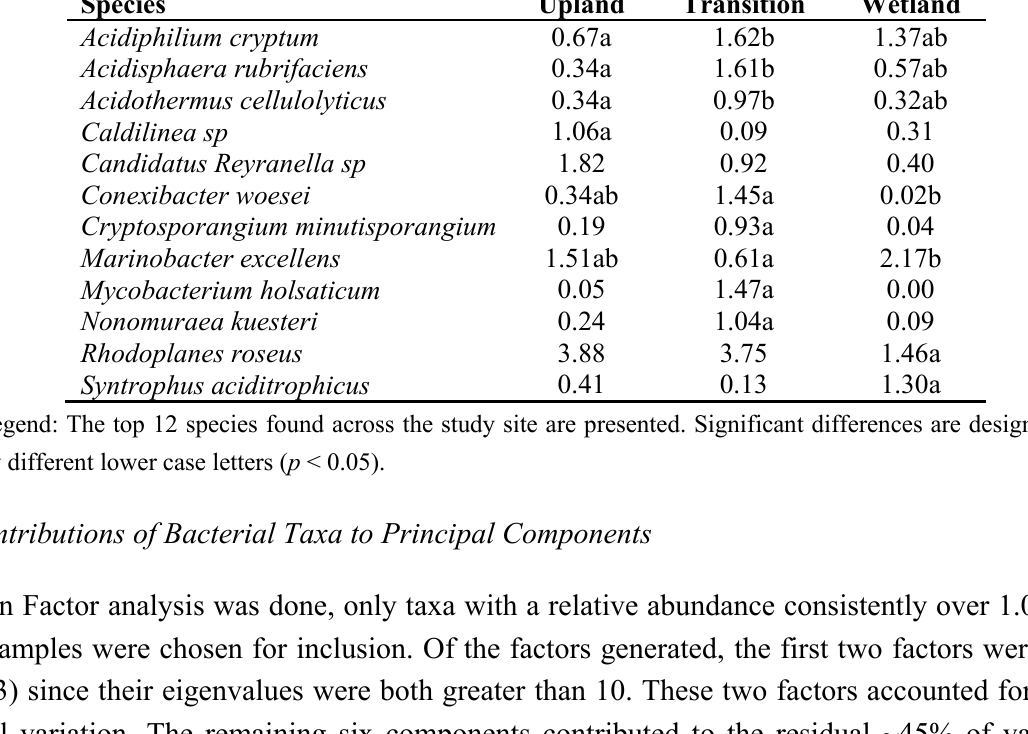
Table 3. Eigenvalues and corresponding values of percentage of variance for each component.